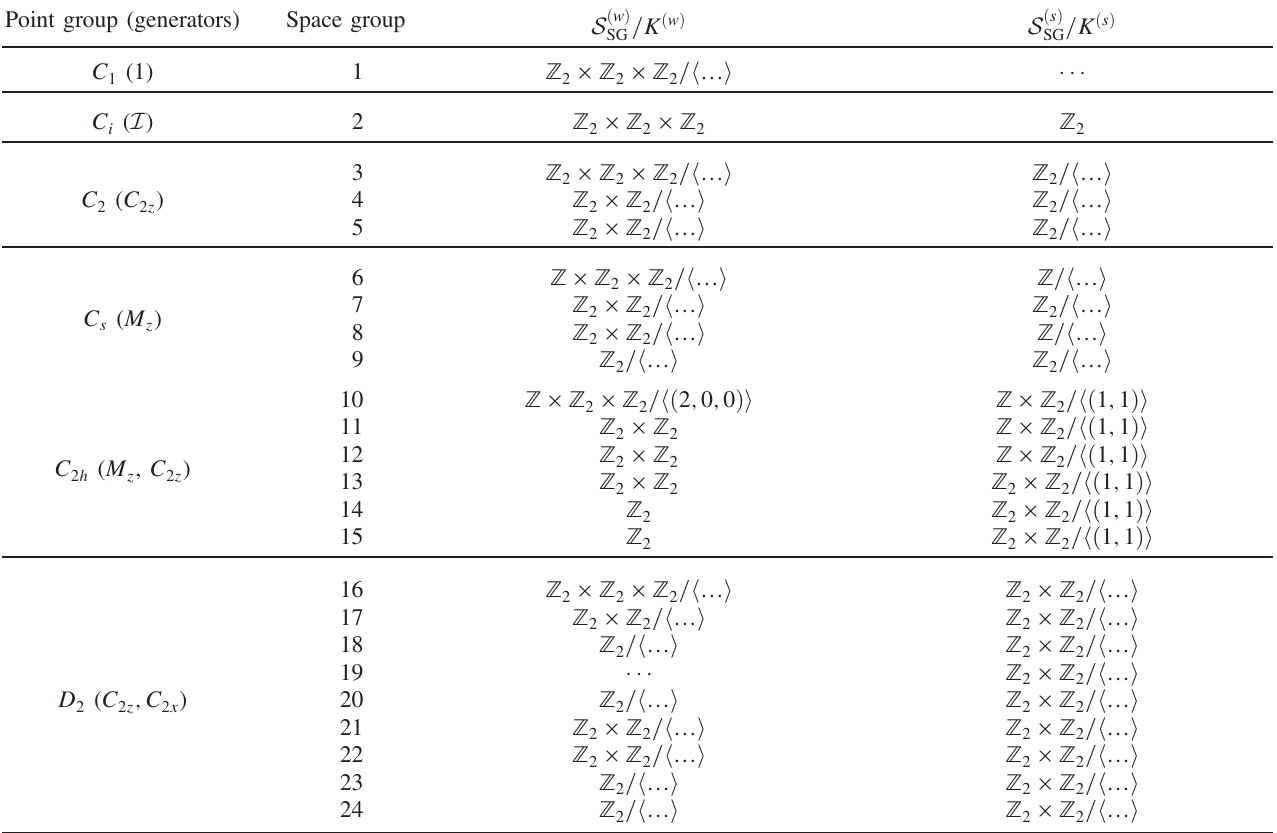
and K explicitly for most SGs. The exceptions are SGs with a trivial K , for SG is trivial, we denote it by a dash. For simplicity, we denote K by h … i when SG . SG